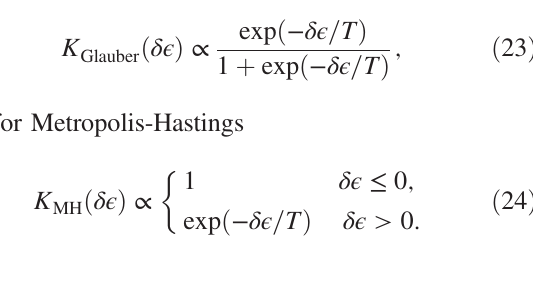
j by choosing a pump strength C